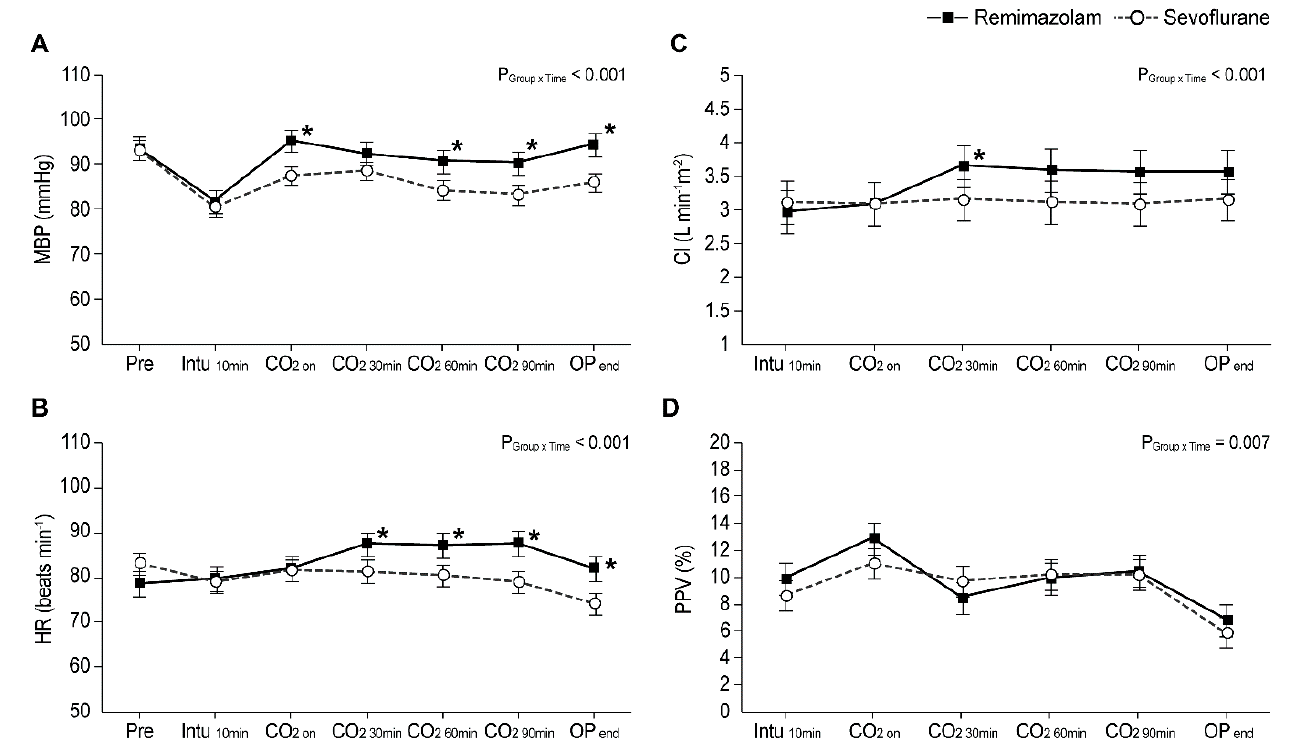
Figure 4. Intraoperative hemodynamic changes in the ( A ) mean blood pressure (MBP), ( B ) heart rate (HR), ( C ) cardiac index (CI), and ( D ) pulse-pressure variation (PPV). Values represent the estimated means from linear mixed models with standard error. PRE, pre-induction; Intu 10 min, 10 min after intubation; CO 2 ON, initiation of CO 2 pneumoperitoneum combined with head-up positioning; CO 2 30min , 30 min after initiation of CO 2 pneumoperitoneum; CO 2 60min , 60 min after initiation of CO 2 pneumoperitoneum; CO 2 90min , 90 min after initiation of CO 2 pneumoperitoneum; OP end, end of operation. * Bonferroni-corrected p < 0.05 vs. sevoflurane group.